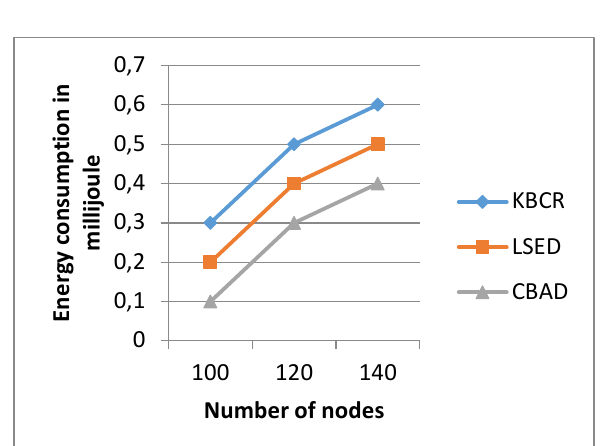
Figure.4 illustrates the comparison performed Comparison between Energy consumption and number of nodes of the novel CBAD and the already available KBCR, LSED methods. It is concluded that the proposed CBAD yields a much better Energy consumption in comparison with the available KBCR, LSED methods.